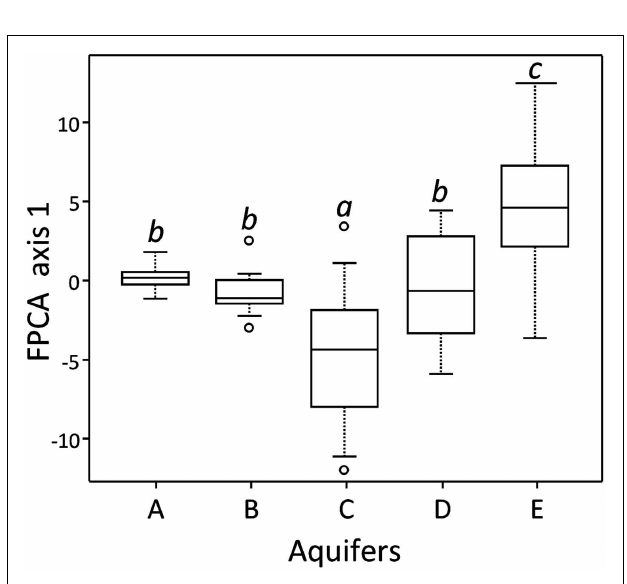
FIGURE 2 | Coordinates of records for the first ordination axis of the FPCA, corrected for “ Methodology ” and grouped by aquifers. Significant differences ( P ≤ 0.05) between sets of coordinates computed with theTukey–Kramer HSD test are indicated with different small